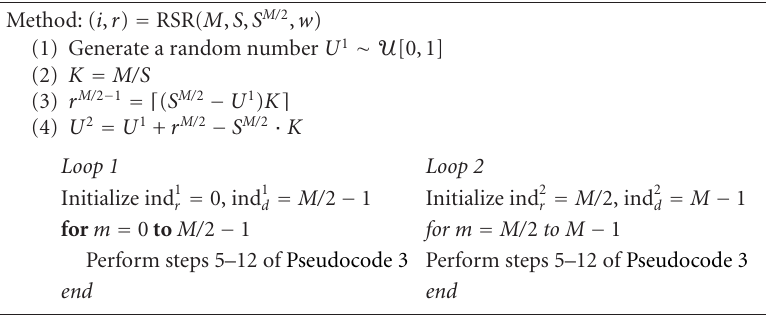
Pseudocode 5: Modified implementation of the RSR